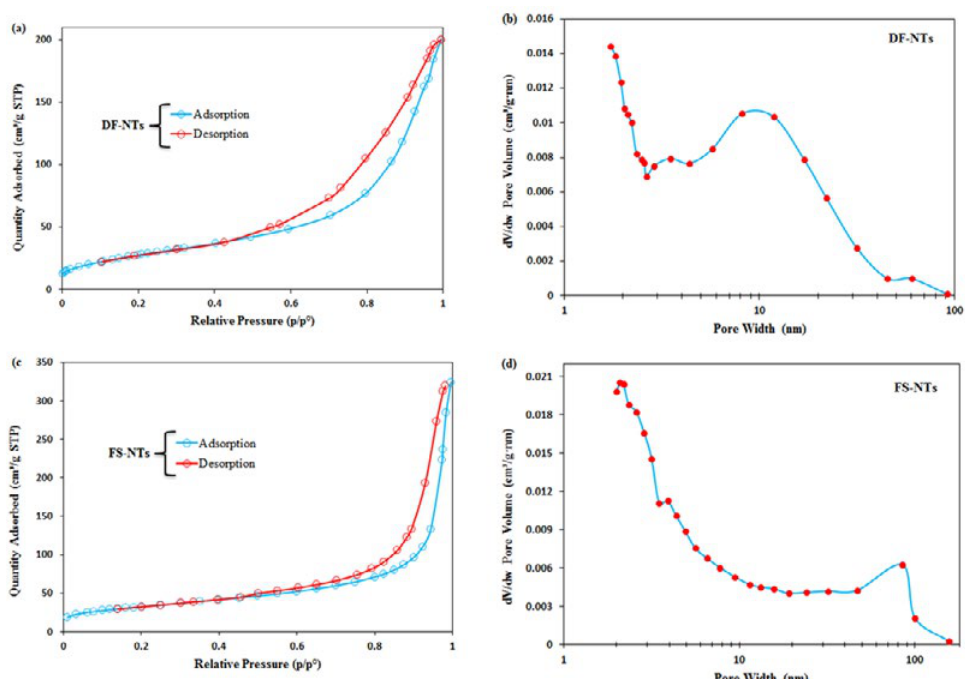
Fig. 5. (a) N adsorption-desorption isotherms and (b) pore distribution of DF-NTs; (c) N 2